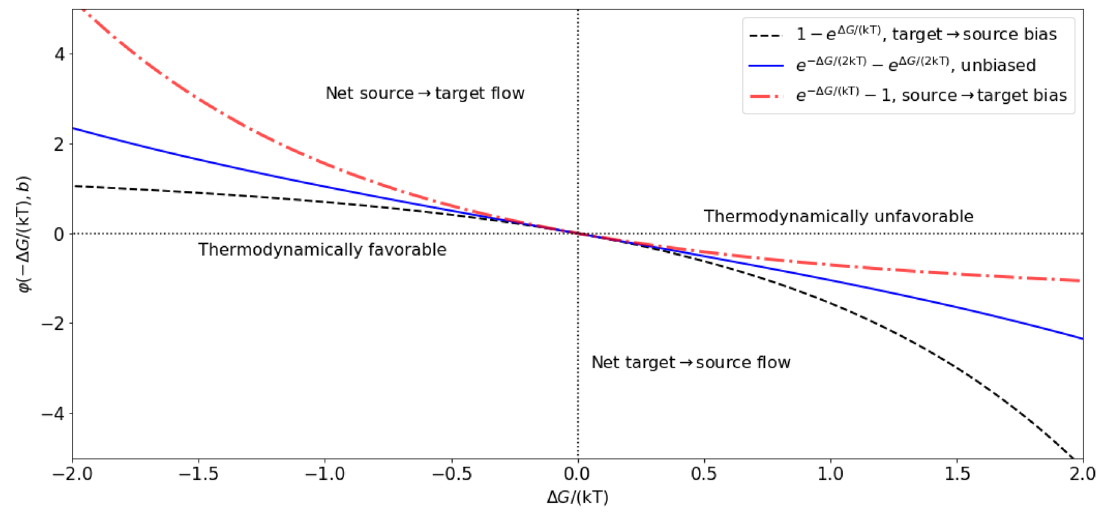
Figure 1. Fluxes biased in the target → source (backward, b =0.1, black dashed line), source → target (forward, b =0.9, red dash-dot line), or showing no rectification ( b =0.5, blue solid line). The energy ∆ G primary active, and on the left axis when transport is secondary active or passive. Extra energy from ATP hydrolysis or other sources added to ∆ G shift the total energy to the left axis and make the transport thermodynamically possible. See Table 1 for S